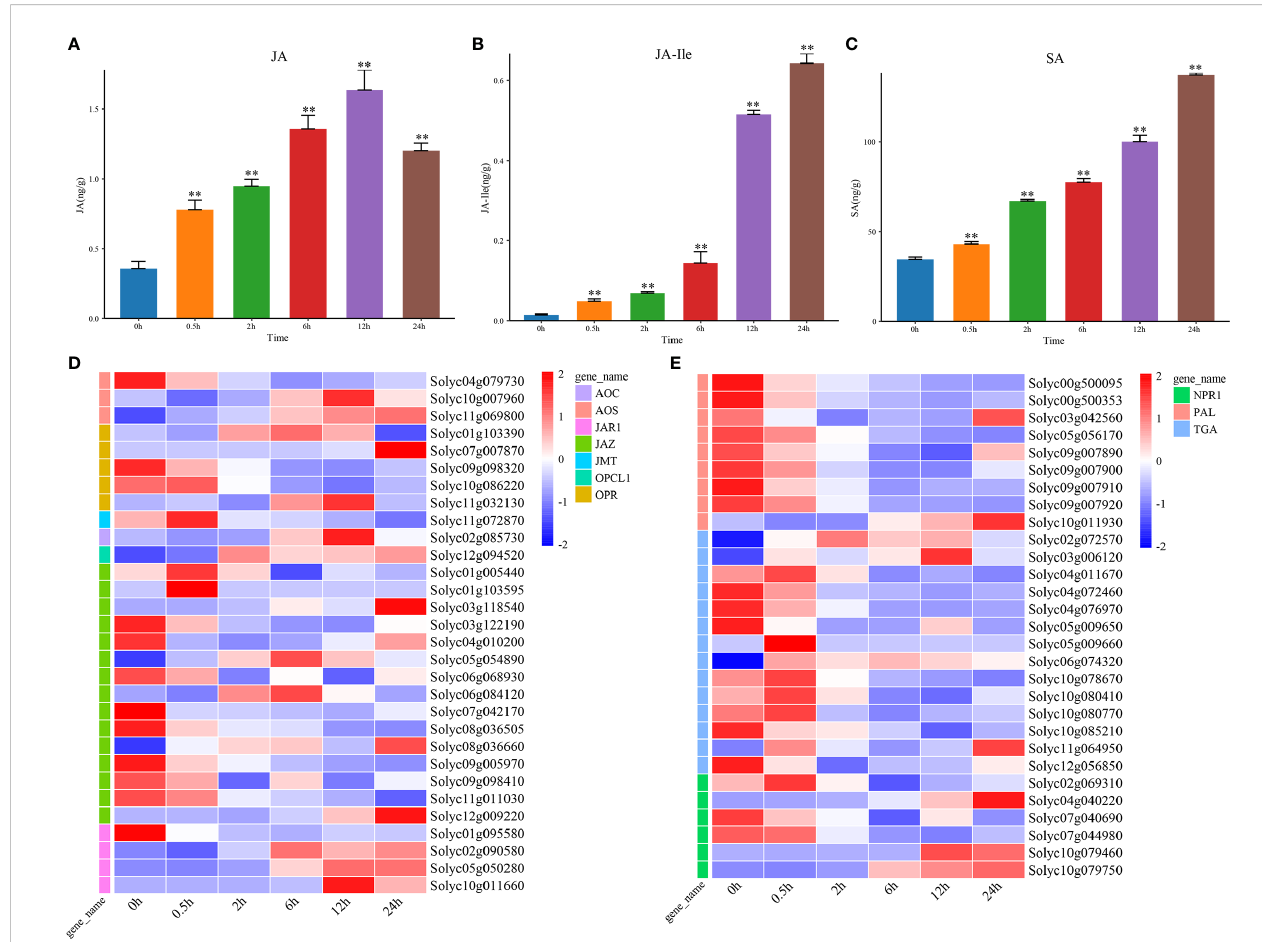
FIGURE 3 The contents of hormone JA and SA, and expression pro fi les of signal transduction genes under salt stress. (A) The content of hormone JA at DTP under salt stress (B) The level of hormone JA-Ile at DTP under salt stress (C) The content of hormone SA at DTP under salt stress (D) The ex-pression pro fi les of DEGs involved in JA biosynthesis and signal transduction at DTP under salt stress (E) The expression pro fi les of DEGs involved in SA biosynthesis and signal transduction at DTP under salt stress (**P-value <